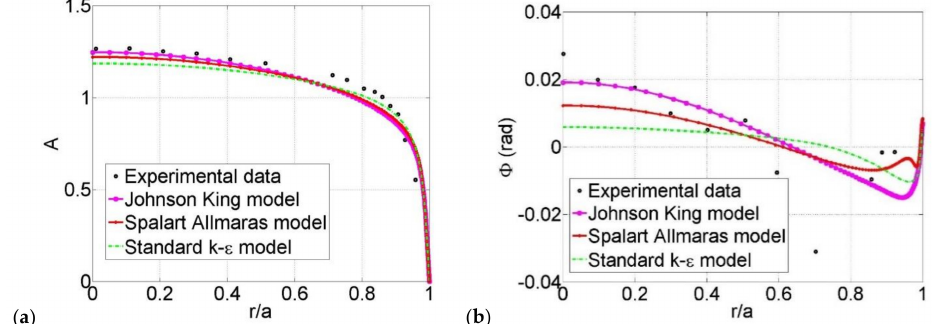
Figure 12. Comparison between the Johnson–King turbulence model and higher-order turbulence models (Case 6: Re os = 20,600, α = 7.9): ( a ) amplitude ratio; ( b )